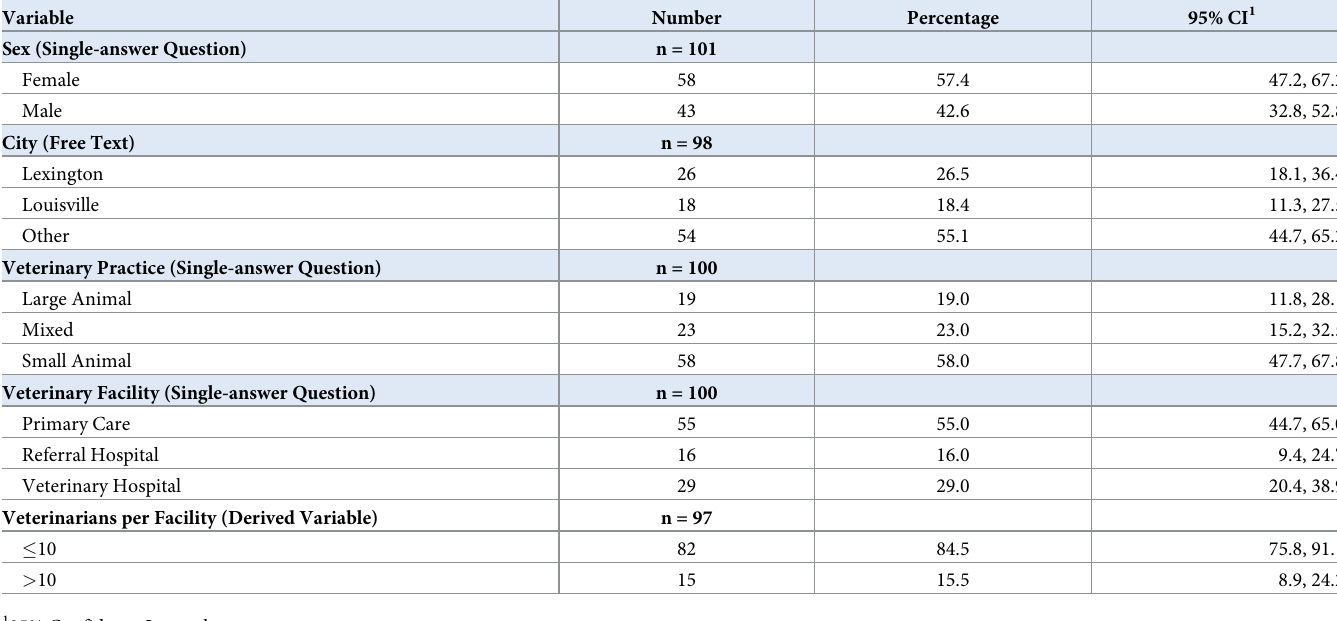
Table 1. Respondent demographic profile from a survey of veterinarians in Kentucky, 2017.